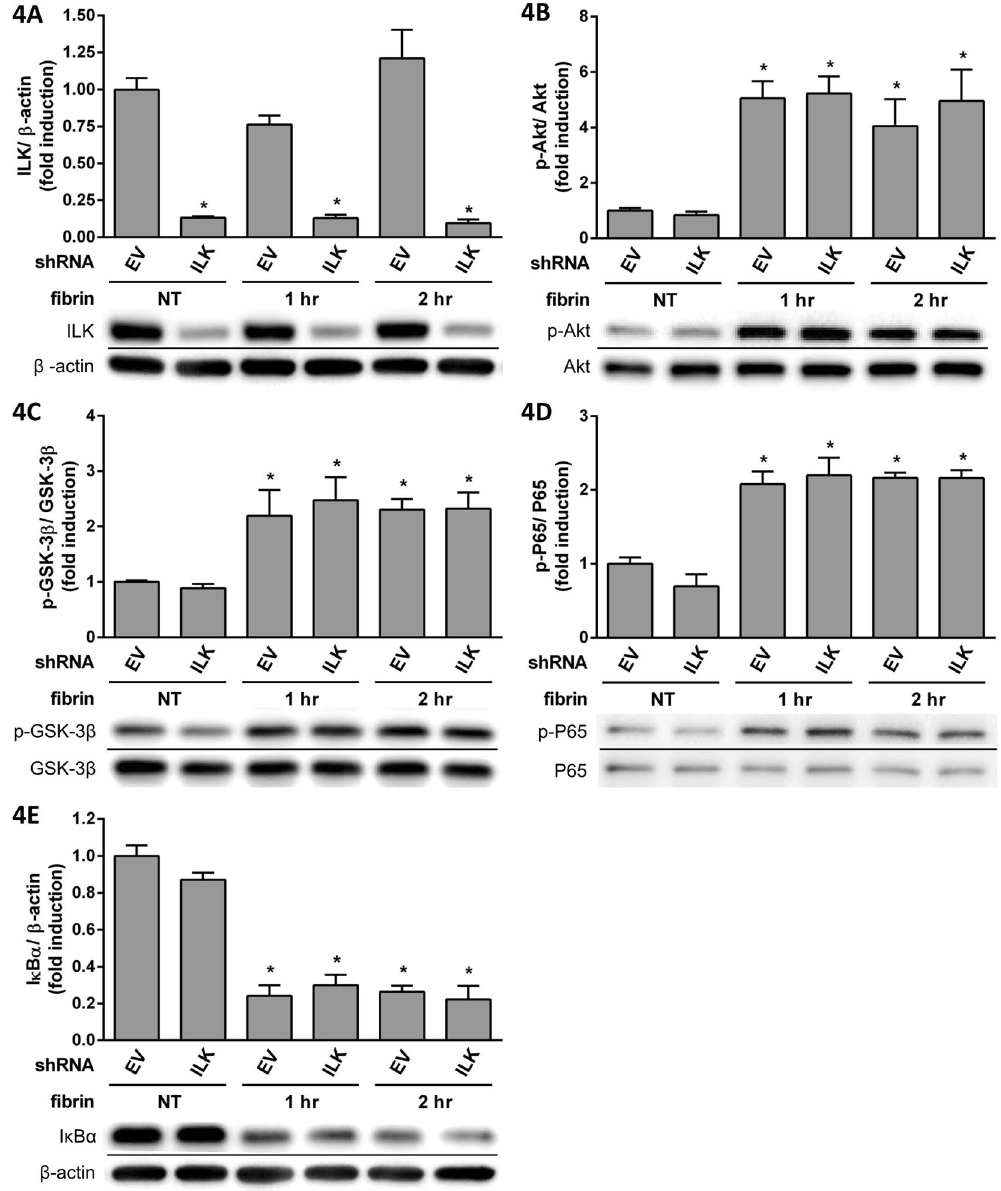
Figure 4. PMCs were infected by lentiviruses carrying either shILK (ILK) or an empty vector (EV) control. PMCs were overlaid with fibrin via incubation with a fibrinogen and thrombin mixture for 0, 1 and 2 hr. Expression of transduction factors were evaluated in triplicate by Western blotting. The relative expression of ( A ) ILK vs. β -actin, ( B ) p-Akt vs. Akt, ( C ) p-GSK-3 β vs. GSK-3 β , ( D ) p-P65 vs. P65 and ( E ) I κ B α vs. β -actin are presented as a percentage of increase over untreated PMCs (NT). * P < 0.05 vs. NT; # P < 0.05 vs. EV at the same incubation